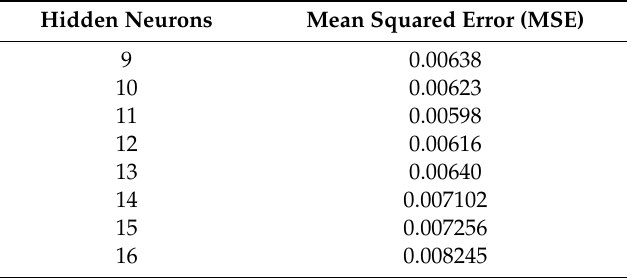
Table 2. Comparison of the back propagation neural network (BPNN)-based model architecture.